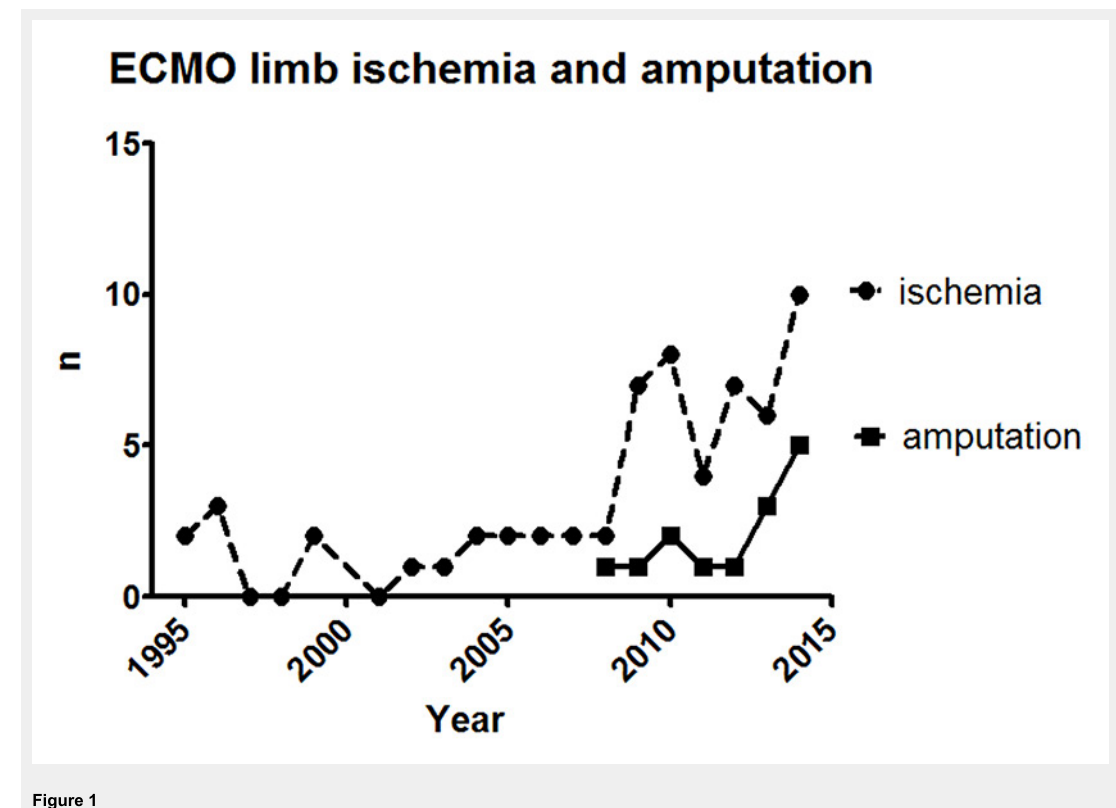
Figure 1 Number of reports on limb ischaemia and amputation in relation to extracorporeal membrane oxygenation